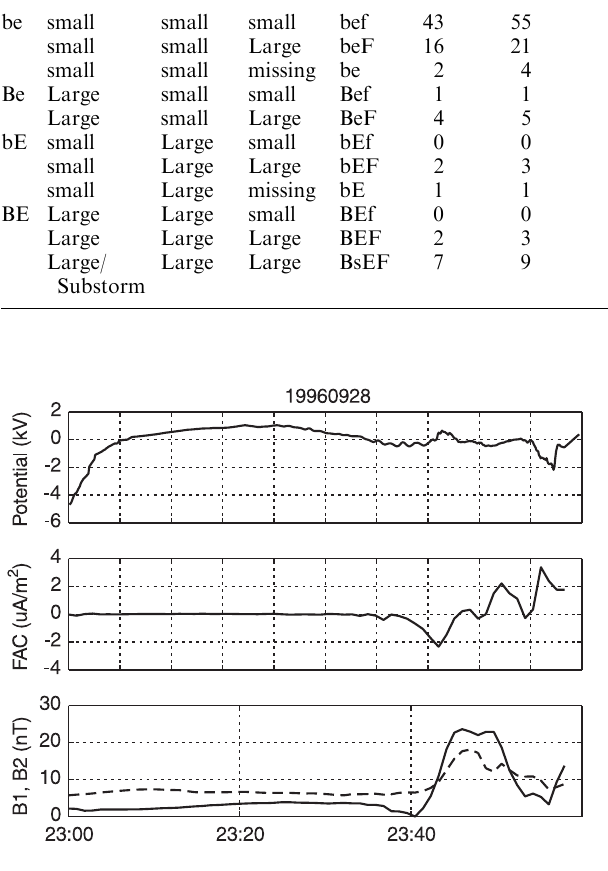
is smaller than B so the 2 1